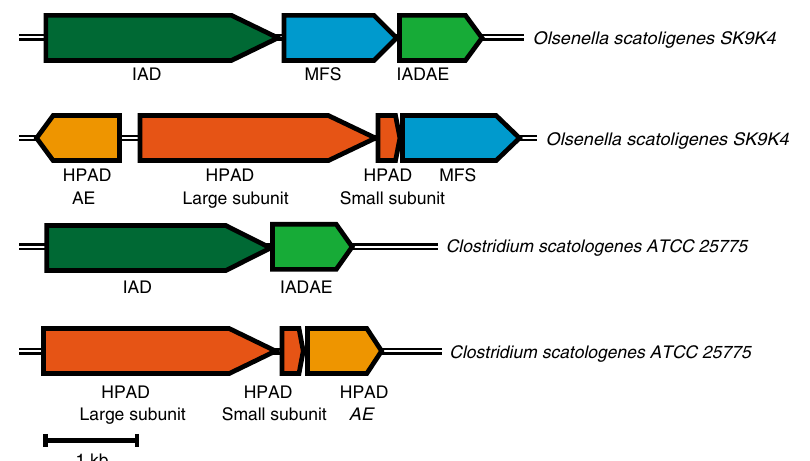
Fig. 3 Genome neighbourhood of IAD and HPAD from Cs and Os . (GenBank accession numbers CP009933 and LOJF01000000 respectively). HPAD p - hydroxyphenylacetate decarboxylase, HPADAE HPAD activating enzyme, IAD indoleacetate decarboxylase, IADAE IAD activating enzyme, MFS major facilitator superfamily